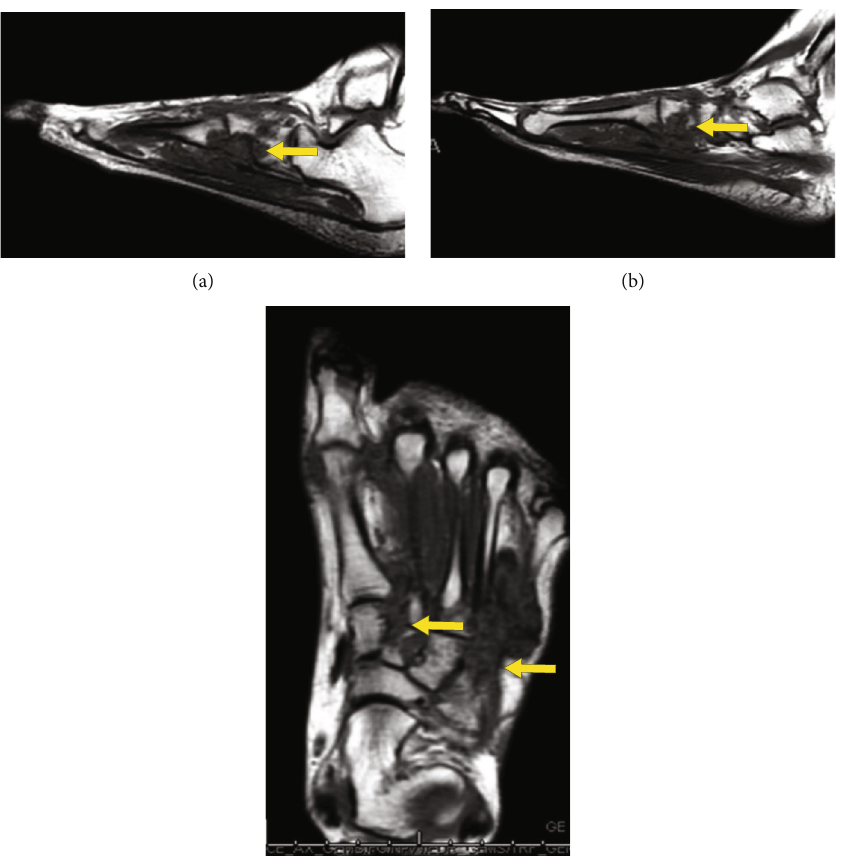
Figure 7: Sagittal and axial images of a 35-year-old female with D-TGCT in the foot. Soft tissue masses at the medial margin of the fi rst metatarsal head and centered about the fi rst through fourth tarsometatarsal joints and extending to the navicular bone appear unchanged, with accompanying bony erosions. These demonstrate low signal on T1 images, compatible with provided history of di ff use tenosynovial giant cell tumor. Low-signal mass dorsal to the fourth tarsometatarsal joint: (a, b) T1 weighted sagittal images of the foot (arrow) and (c) T1 weighted axial view of the foot